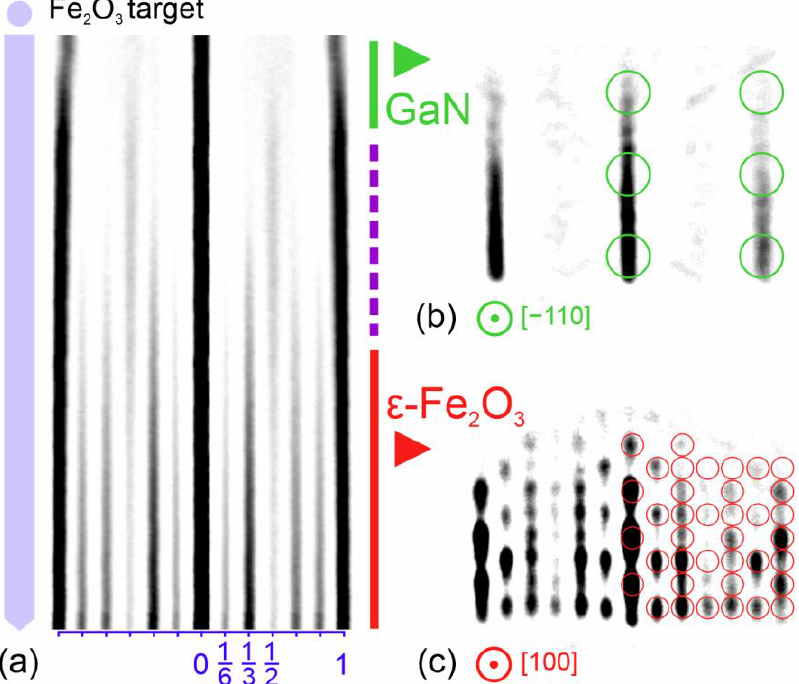
Figure 2. Time-dependent RHEED profile map ( a ) showing nucleation of the orthorhombic ε -Fe 2 O 3 phase on hexagonal GaN. The map height corresponds to deposition of about 20 Å of Fe 2 O 3 . The corresponding RHEED patterns of GaN ( b ) and ε -Fe 2 O 3 ( c ) illustrate the initial and final stages of the nucleation process.